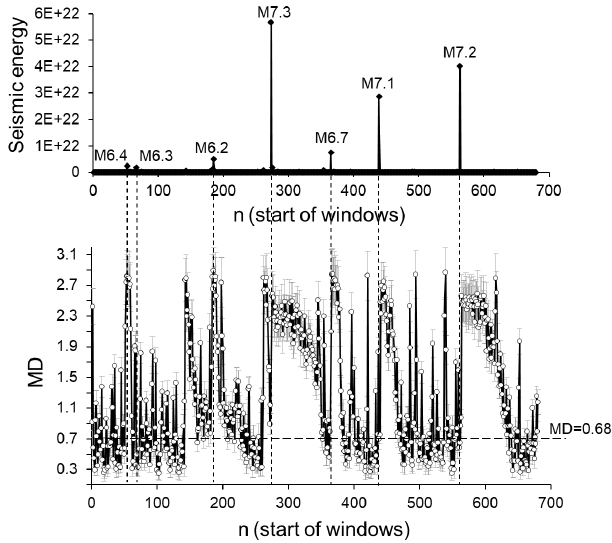
Figure 5. Seismic energy released (upper curve) and average MD values (bottom curve) calculated for consecutive non-overlapping 50-data windows shifted by 50 data steps, for the southern Califor- nia earthquake catalogue (1975–2017). Averages of the MD values and the corresponding standard deviations (given in the lower plot by white circles and grey error bars) were calculated by comparing ICT( i ), ICD( i ), and ICE( i ) sequences in the original catalogue and in the set of randomised catalogues. The dotted line corresponds to a significant difference between windows at p = 0 .